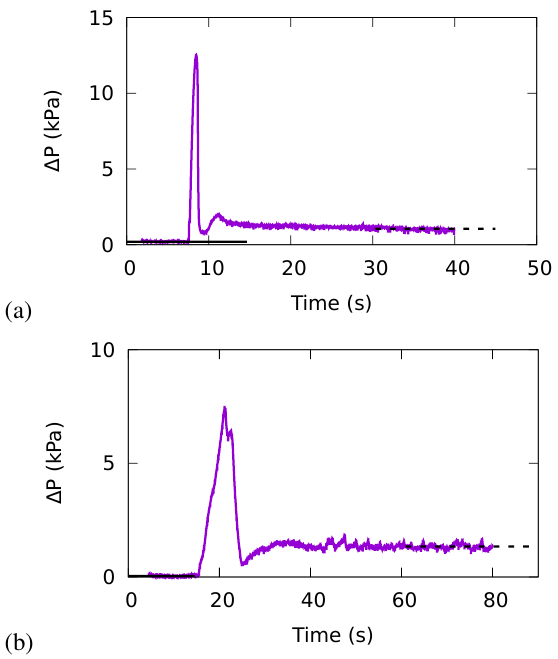
Figure 3. Spatio-temporal diagrams obtained from a section of the tube of length 234 mm located left of the tube’s outlet so that the imposed flow rates (a) I 0 = 1 mL.min − 1 , (b) I 0 = 2 mL.min − 1 , and (c) I 0 = 3 mL.min − 1 , are oriented rightwards. Time develops downwards for 231